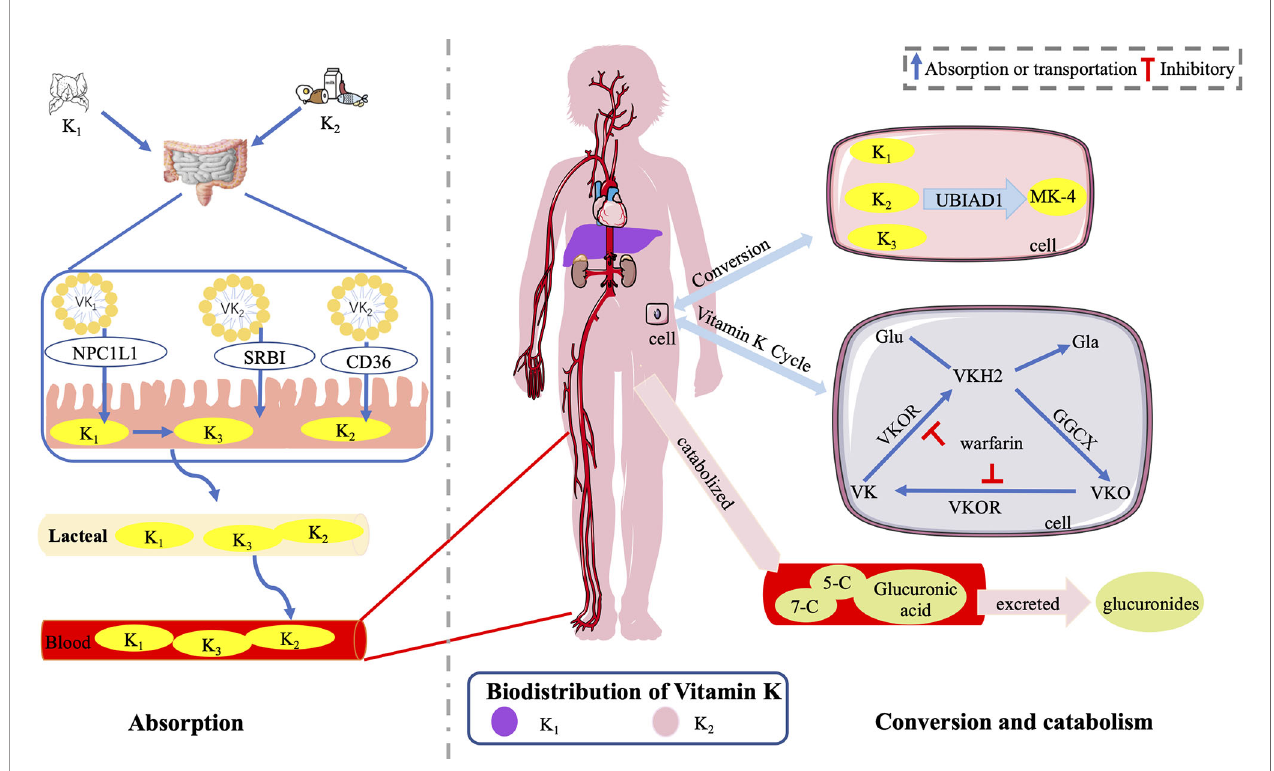
FIGURE 4 | Absorption, distribution, and catabolism of VK. Once the dietary VK reaches the intestinal lumen, it is absorbed into mixed micelles through the NPCIL1 protein, SR-BI, and CD 36. Mixed micelles are absorbed by small-intestinal enterocytes, incorporated into CM, and secreted from gut villi into lacteals. Then, they join the larger lymphatic vessels where they are released through the thoracic duct into the bloodstream. K 1 is converted into K 3 in the gut, delivered to tissues, and subsequently converted into MK-4 with UBIAD1. K 1 is retained in the liver, while K 2 is redistributed to the circulation and (extra-)hepatic tissues (51). VK epoxide cycle involving GGCX and VKOR, which is responsible for VK regeneration by converting into VK, VKH 2 , and VKO. In humans, the polyisoprenoid side chain of VK is catabolized into two major carboxylic acid metabolites of 7- and 5-carbon side chains. Then, after glucuronic acid conjugation, it is fi nally excreted as glucuronides in the bile and urine primarily. The fi gure is in a non-editable